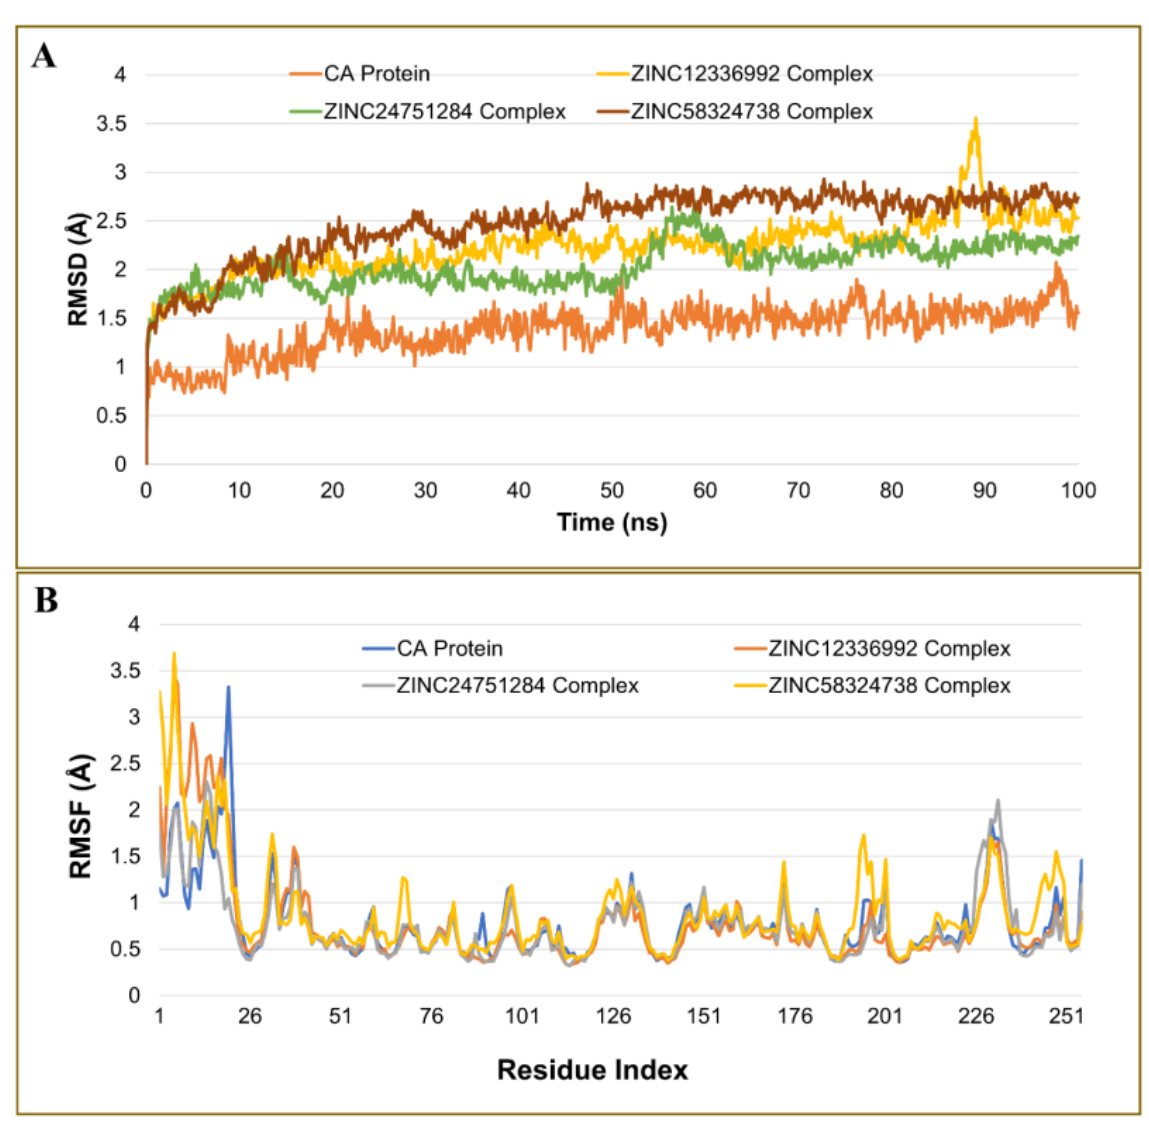
Figure 5. Plot of molecular dynamics simulation trajectories of carbonic anhydrase apo protein, and protein–ligand complexes during a 100-ns MD simulation showing the root mean square deviation (RMSD) ( A ) and root mean square fluctuation (RMSF) ( B ).